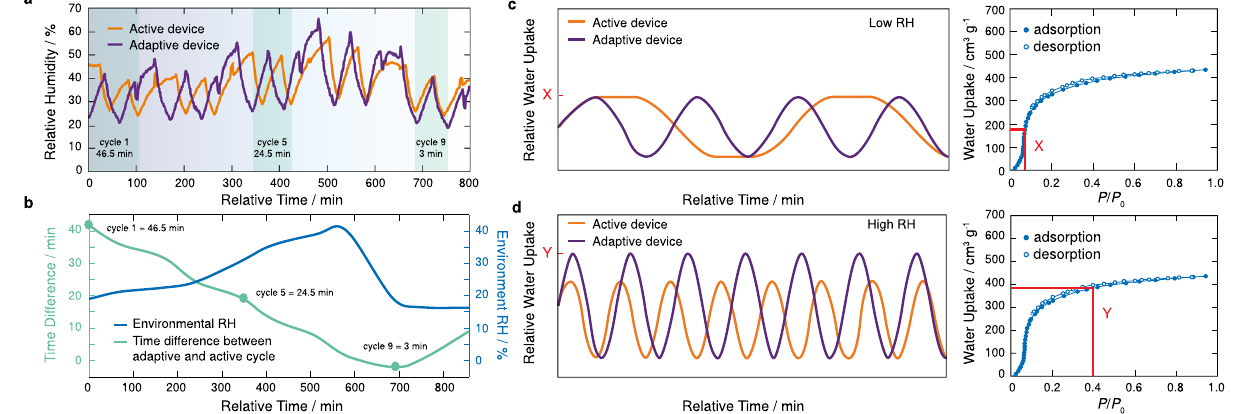
Fig. 4 | Performance evaluation of adaptive water harvesting. a Relative humidity (RH) response for the active (orange) and adaptive (purple) devices operating under the same environmental conditions (20 – 46% RH) during an arbi- trary portion of the same day. The cycle time demonstrates the optimized perfor- manceoftheadaptivedevicethroughoutthedaywithlesstimeconsumedpercycle. b Time difference pro fi le between cycles carried out by the adaptive and active devices with changing environmental RH throughout the day. As environment RH increases (blue), the adaptive and active cycle time difference decreases (green). c The conceptual principles underlying the differences in cycling rates for the adaptive and active devices. In low RH, the pre-programmed adsorption phase of